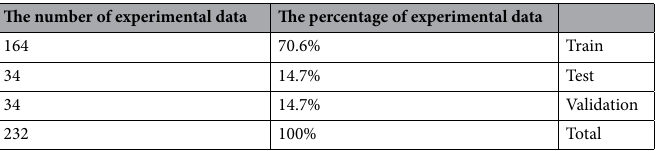
Table 3. The number and percentage of experimental data used for training, testing and validation in artificial neural